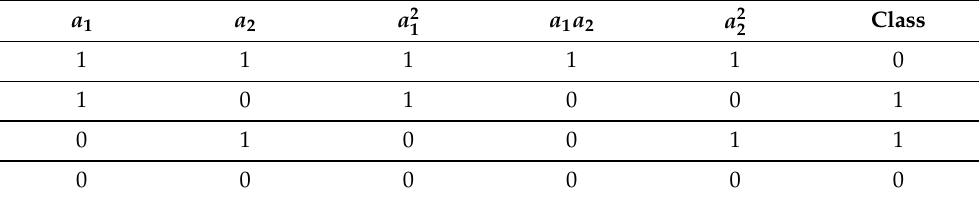
Table 3. XOR function under 2-monomial expansion. a 1 a 2 a 2